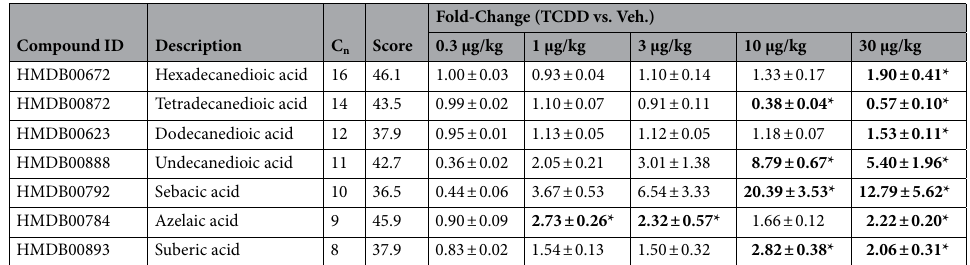
Table 2. Induction of dicarboxylic acid levels by TCDD. Dicarboxylic acid levels were assessed in mice using untargeted liquid chromatography tandem mass spectrometry. Mice (n = 4–5) were orally gavaged every 4 days for 28 days with sesame oil vehicle or TCDD. Fold-changes were calculated for each treatment group relative to the vehicle control group. Bold font and asterisks (*) denote statistical significance ( p ≤ 0.05) determined using a one-way ANOVA with Dunnett’s post-hoc analysis. Scores were determined by Progenesis with 60 being the maximum value and 0 being the minimum value. Scores ranging from 30—40 are based on mass error and isotope distribution similarity, while score > 40 are based on mass error, isotope distribution and fragmentation score. All annotated compounds have a score distribution averaging ~